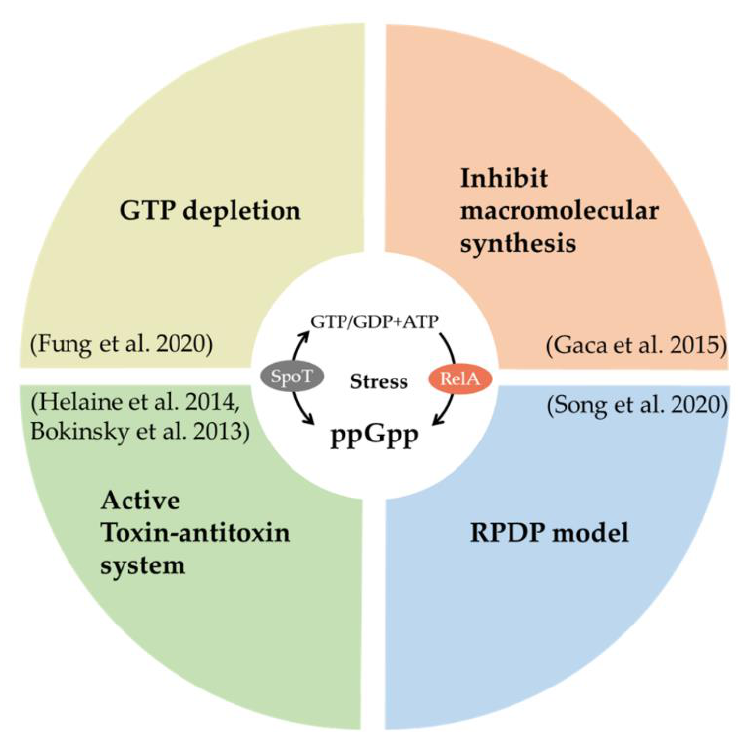
Figure 3. Functions of ppGpp associated with persister formation after being generated by a RelA/SpoT homolog family. RPDP model: ribosome dimerization persister model.